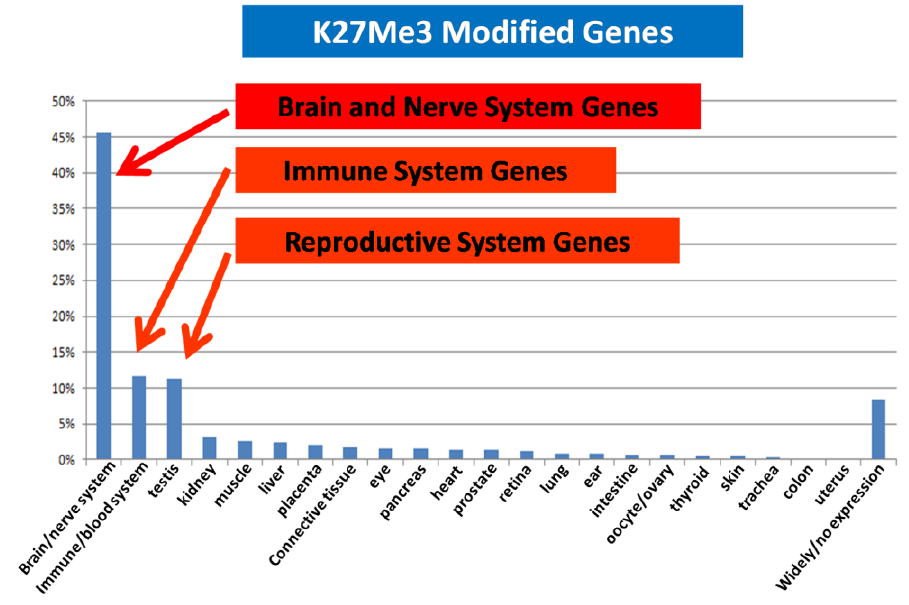
Figure 8. H3K27Me3 modification in the MCF-7 genome is enriched for brain, immune and reproductive